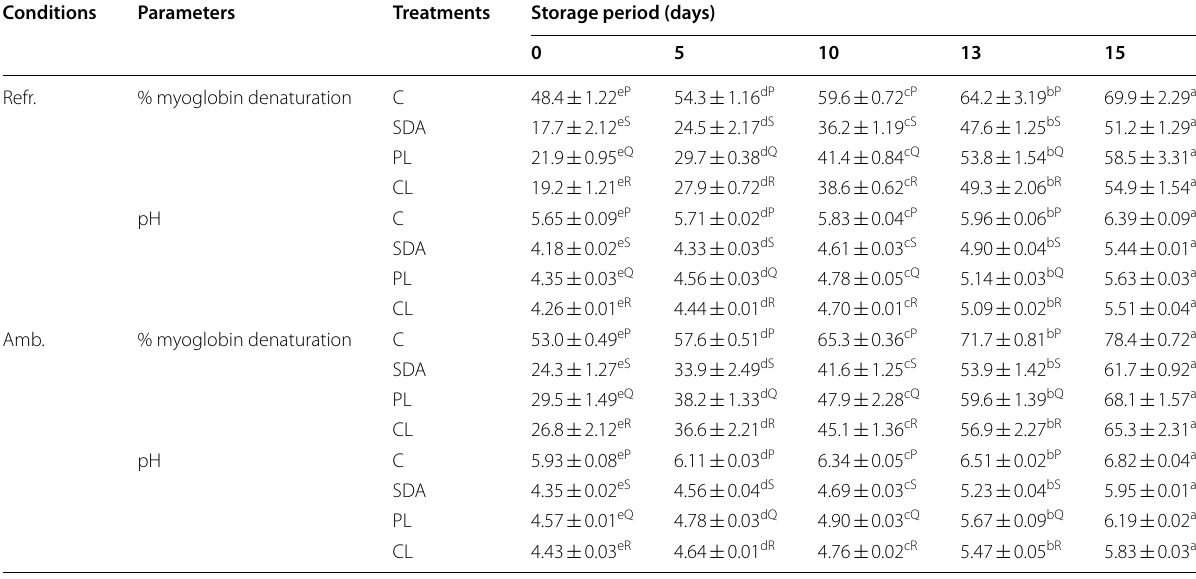
All values are mean standard deviation of three replicates ( n ± Values followed by the same letter in a row and the column do not differ significantly ( p within a column C: control; SDA: gravy treated with 0.25% sodium diacetate; PL: gravy treated with 2.5% potassium lactate; CL: gravy treated with 2.5% calcium